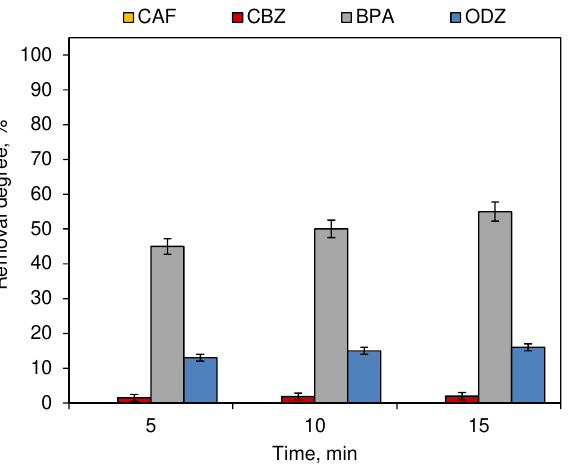
Figure 4. Influence of the O 3 contact time on the removal degree of CECs (dark chamber experiment;